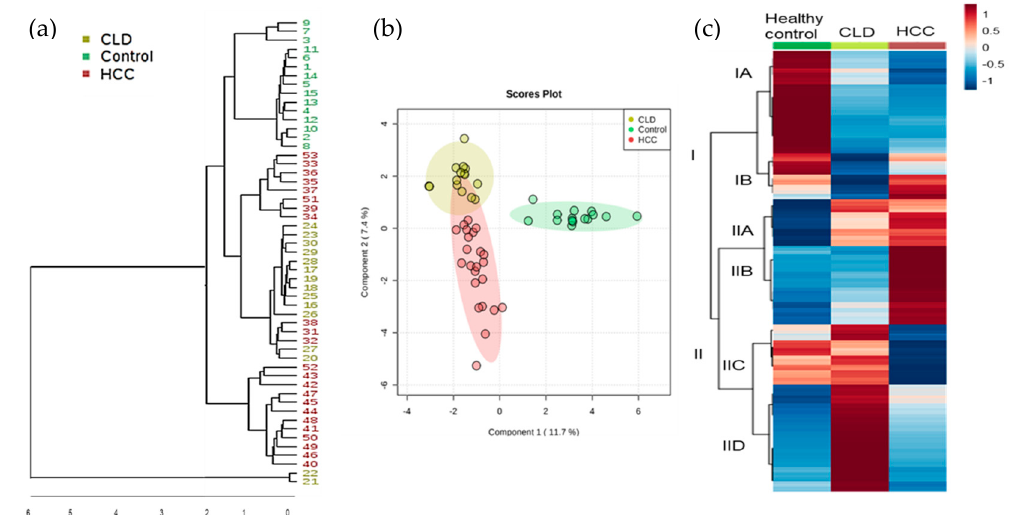
Figure 1. Multivariate clustering of blood-based metabolomics data using GC-TOF mass spectrometry. ( a ) Unsupervised hierarchical clustering of all 730 detected metabolites in the studied groups HCC, Chronic Liver Disease (CLD), and healthy control. ( b ) Supervised sparse partial least squares-discriminant analysis of all 730 metabolites to better distinguish metabotypes of study groups. ( c ) Clustering of 510 significant metabolites (Mann–Whitney U test p < 0.05 and qFDR < 0.1) across the three test groups, range-scaled from increased ( + 1, red) to decreased ( − 1,